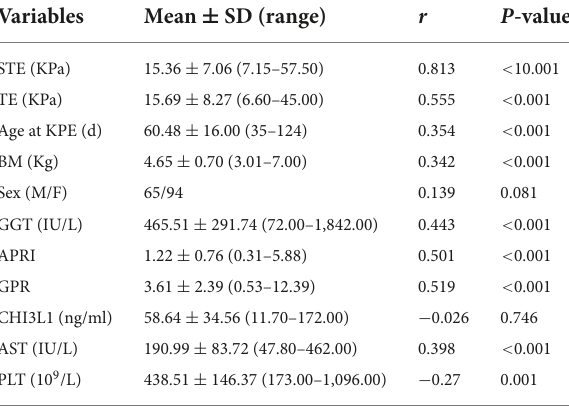
TABLE 2 Correlation of various variables with hepatic fibrosis